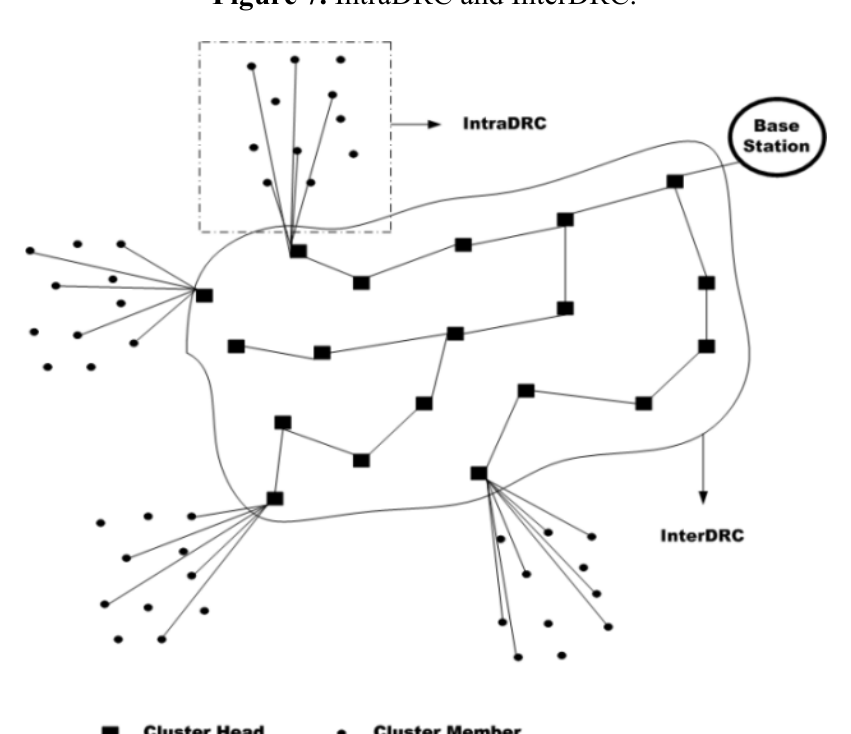
Figure 7. IntraDRC and